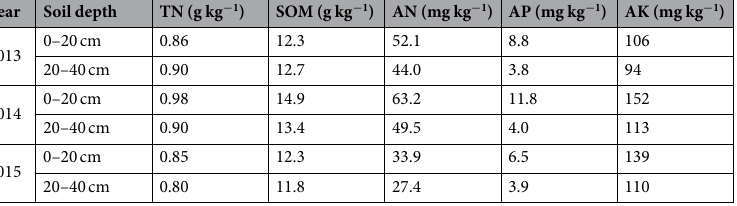
Table 5. Soil chemical properties in the 0–40 cm soil layer in experimental fields at Pengyang Experimental Station, Ningxia Province, China during 2013–2015. Note: TN = total nitrogen; SOM = soil organic matter; AN = available nitrogen; AP = available phosphorus; AN = available potassium.